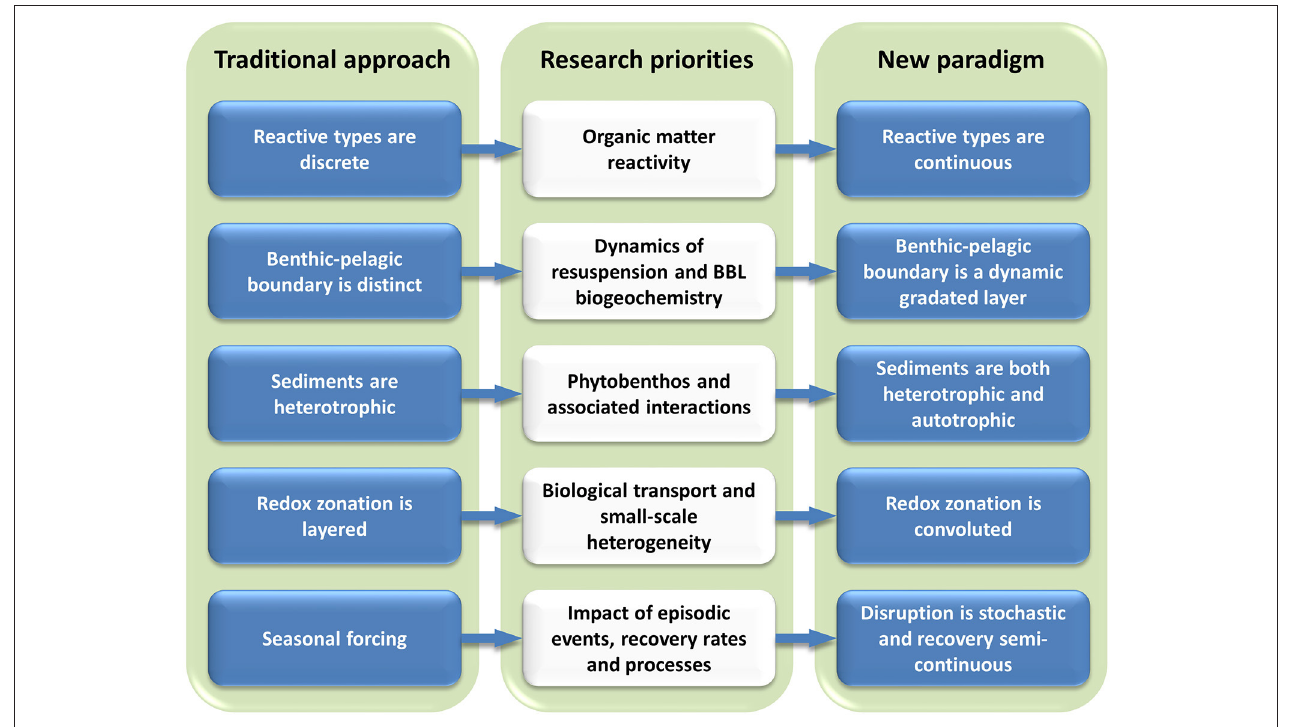
FIGURE 1 | Traditional view of benthic-pelagic coupling and approach to its representation in models (Left) , the five cross-disciplinary research priorities that challenge this traditional approach (Middle) , and lead to the new paradigm (Right) , which is crucial for the improvement of biogeochemical and ecological modelling studies of the marine